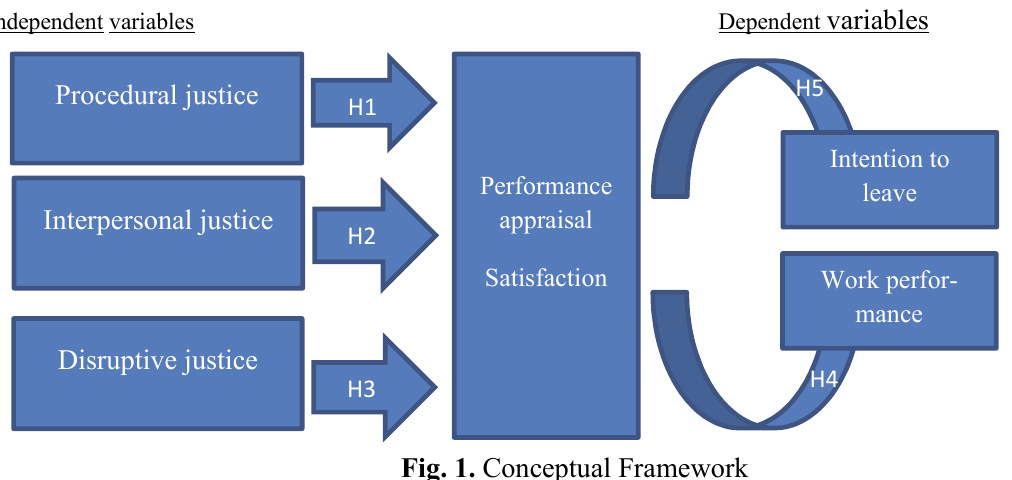
Fig. 1. Conceptual